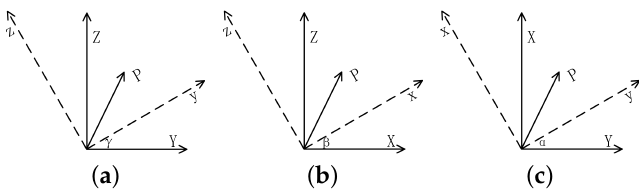
Figure 3. Revolution around the ( a ) X , ( b ) Y , and ( c ) Z axes of G